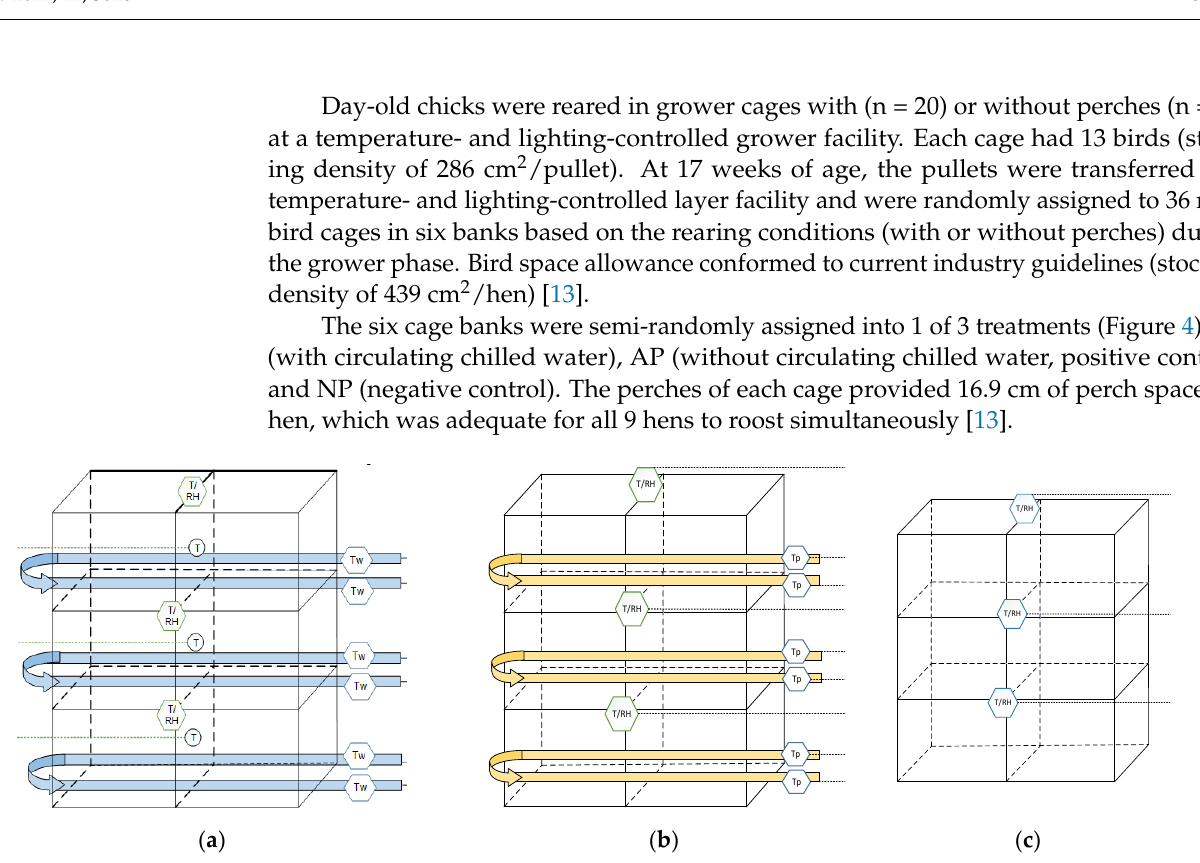
Figure 4. Cage bank design for the 3 treatments of: ( a ) cooled perch (CP) cages; ( b ) air perch (AP) cages; and ( c ) control cages with non-perch cages (NP). Two perches were installed parallel to each other in each row of a cage bank, forming a complete loop. For CP cages, a manifold was used to supply the perch loops with chilled (10 ◦ C) water (Figure 1). Each CP loop was independently controlled by a thermostat-activated water pump, activated when the cage air temperature exceeded 25 C (Figure modified from [42,43]).